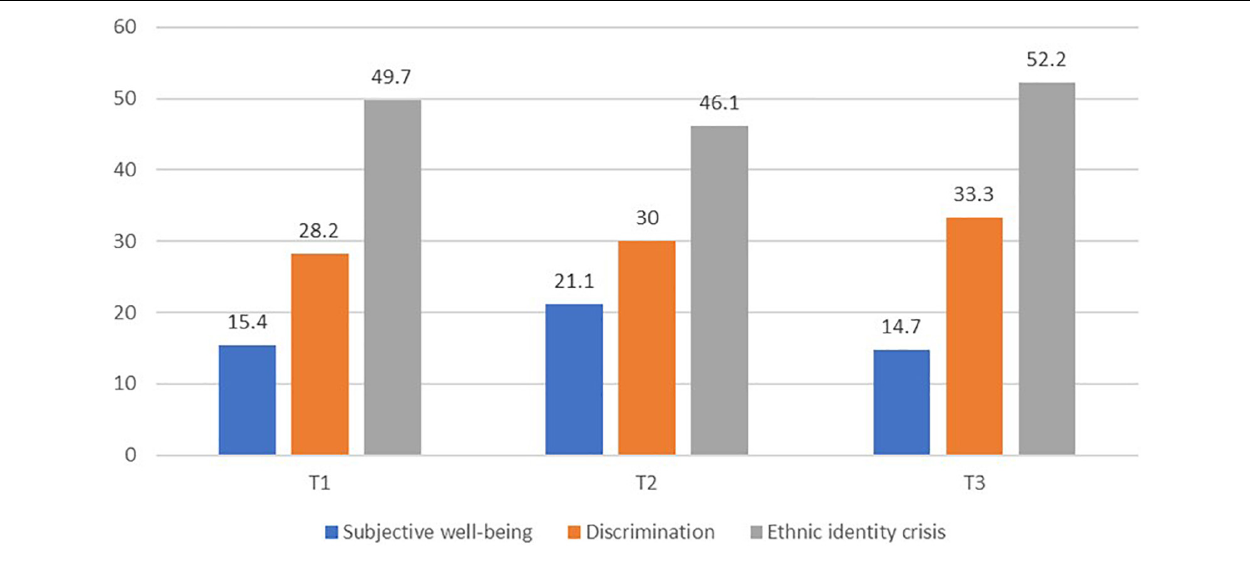
[robust χ 2 ( 33 ) = 55.40, p = 0.009; CFI = 0.939; RMSEA = 0.037, 90% CI (0.019, 0.054); SRMR = 0.070]. Constraining all twelve cross-lagged paths as equal (Model 2) (e.g., all cross-lagged paths going from SWB to discrimination and ethnic identity